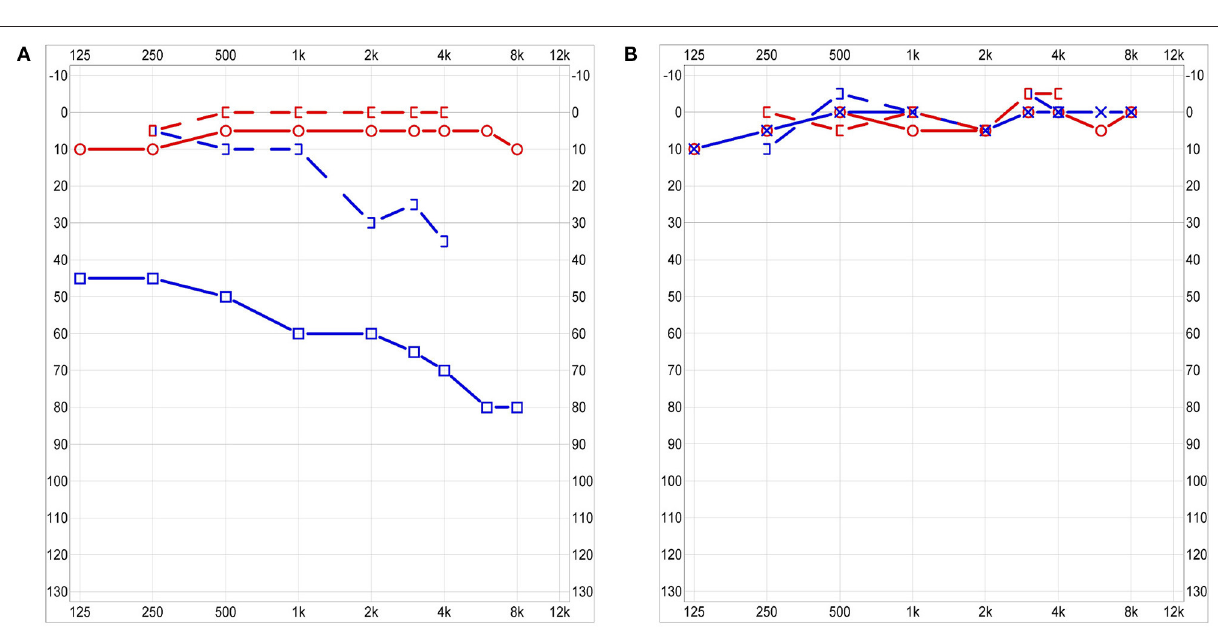
FIGURE 4 | Audiogram 3 days post-admission: moderate to severe combined hearing loss on the left with normal hearing on the right side (A) . Audiogram at 3 months follow-up: Symmetrical normal hearing (B)